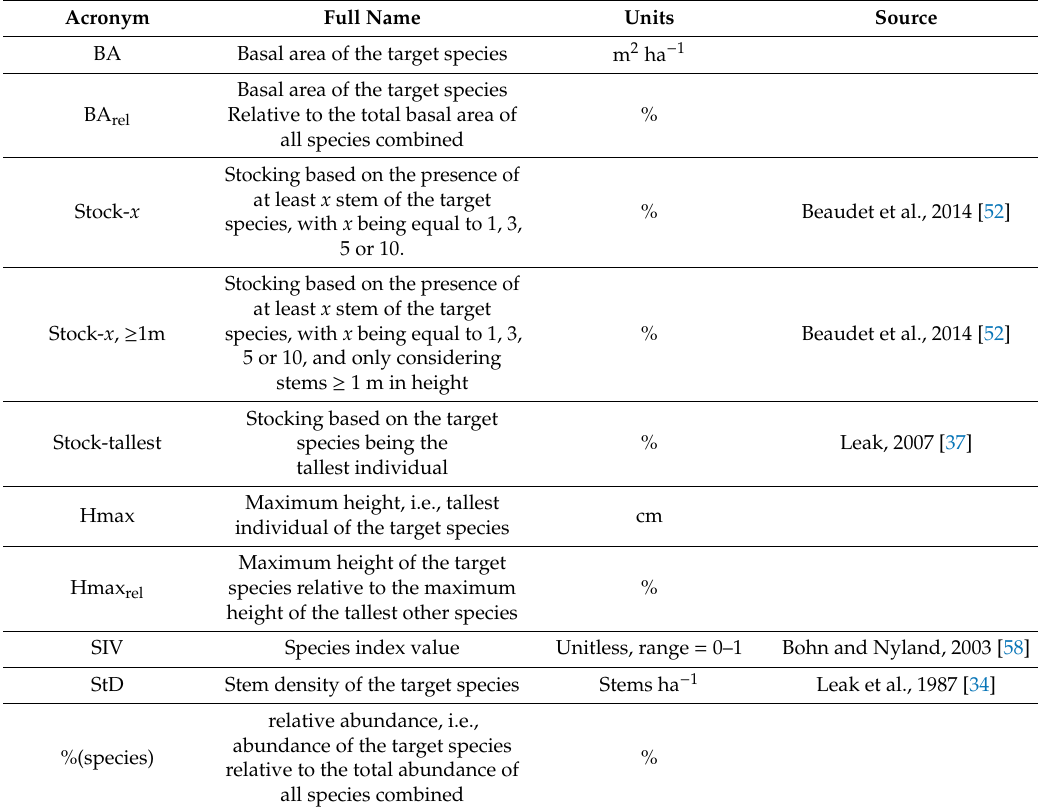
Table 2. List of the 16 regeneration indices used in the present study, and their literary sources, when